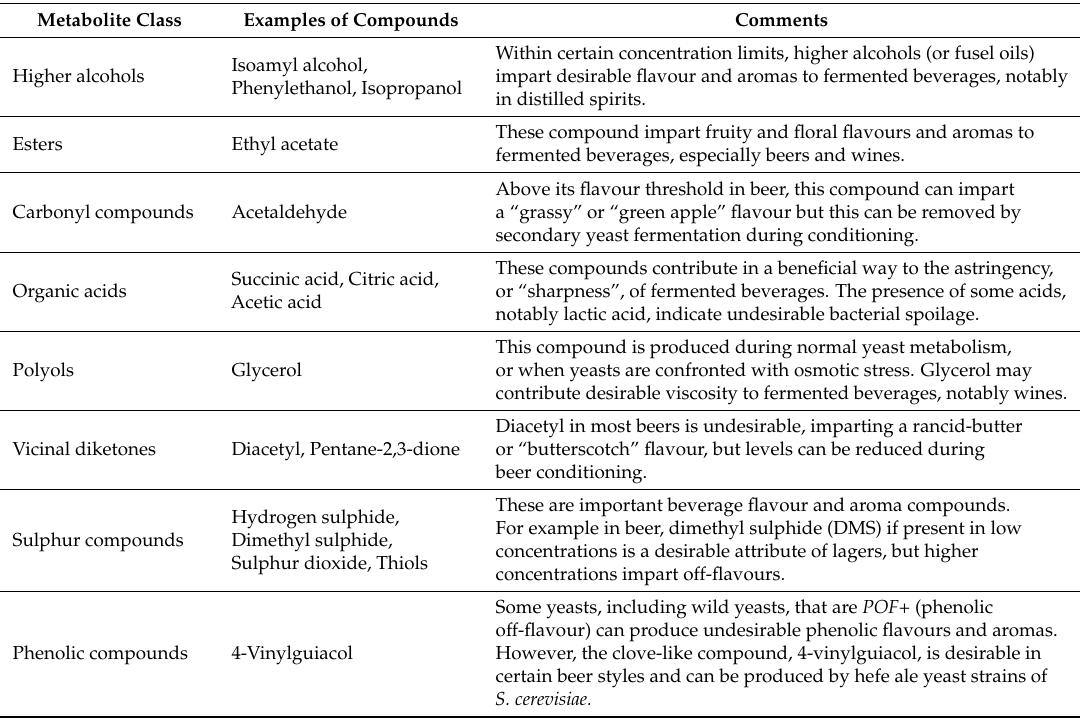
Table 4. Yeast secondary fermentation metabolites as beverage